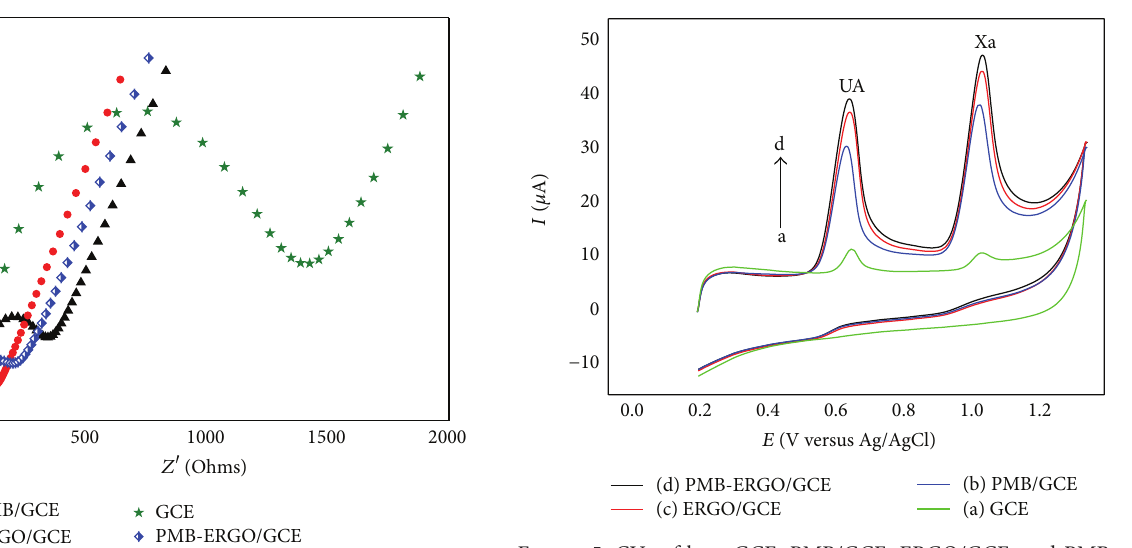
Figure 4: EIS of GCE, PMB/GCE, ERGO/GCE, and PMB-ERGO/ GCE in 5.0 × 10 −3 M K 3 [Fe(CN) 6 ], 1.0M KCl solution with initial 𝐸 for 150mV, high frequency for 2000 Hz, low frequency for 0.05 Hz, and A.C. amplitude for 150mV.